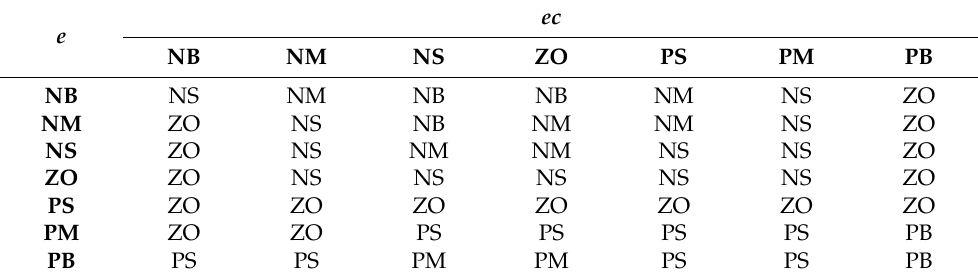
Table 3. Fuzzy control rules of ∆ K d